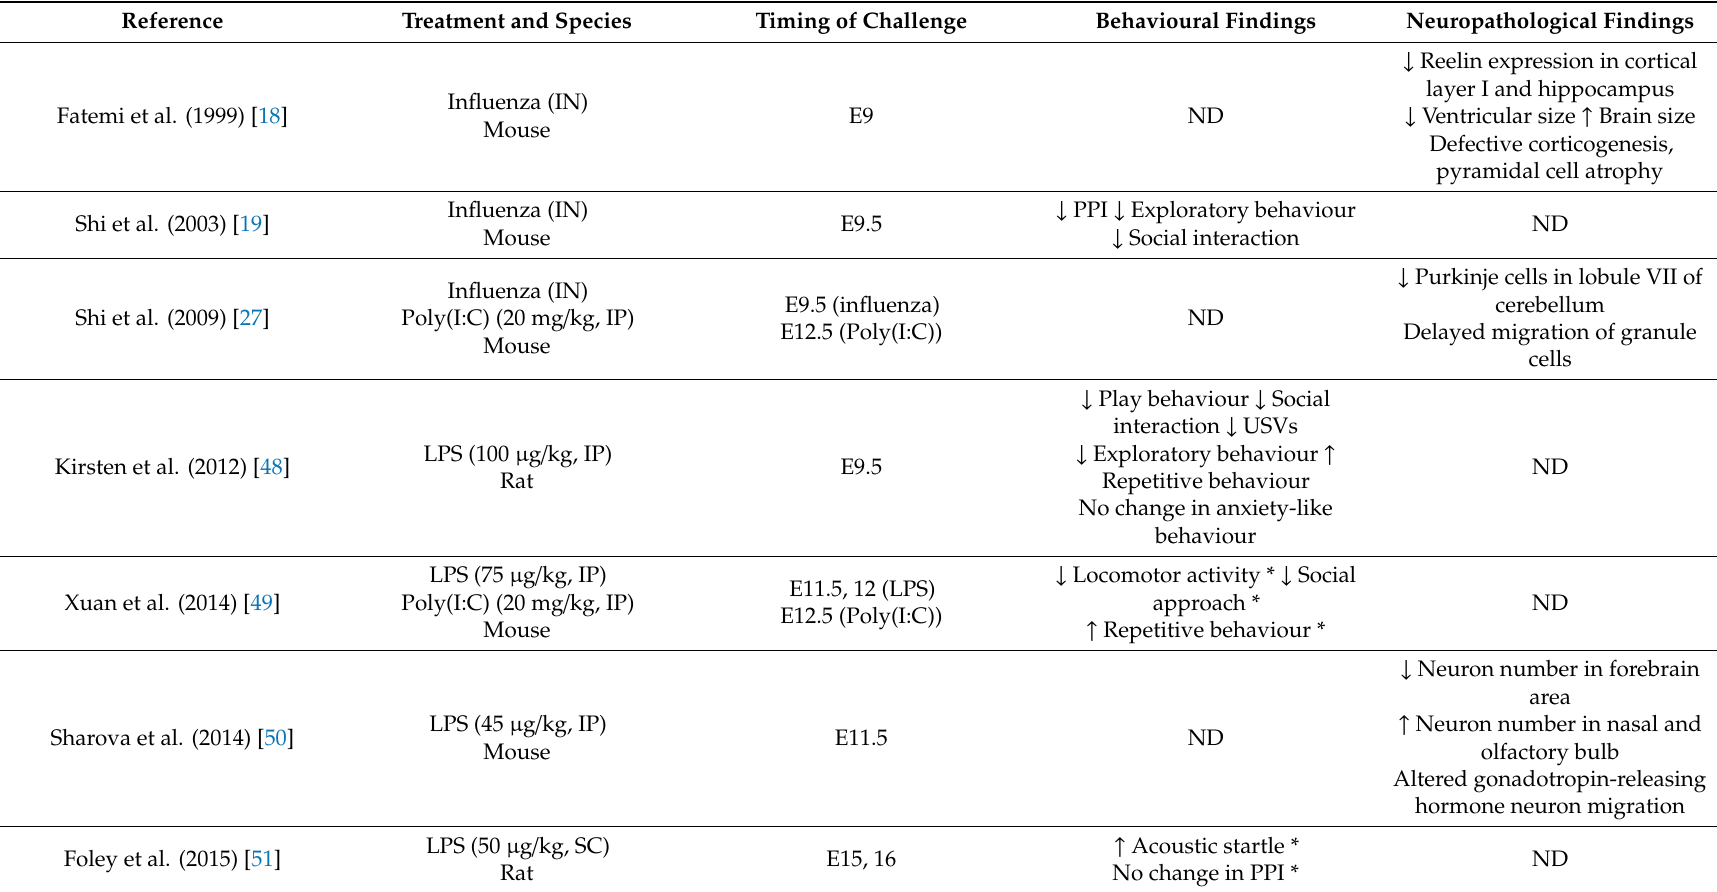
Table 1. Rodent models of maternal immune activation